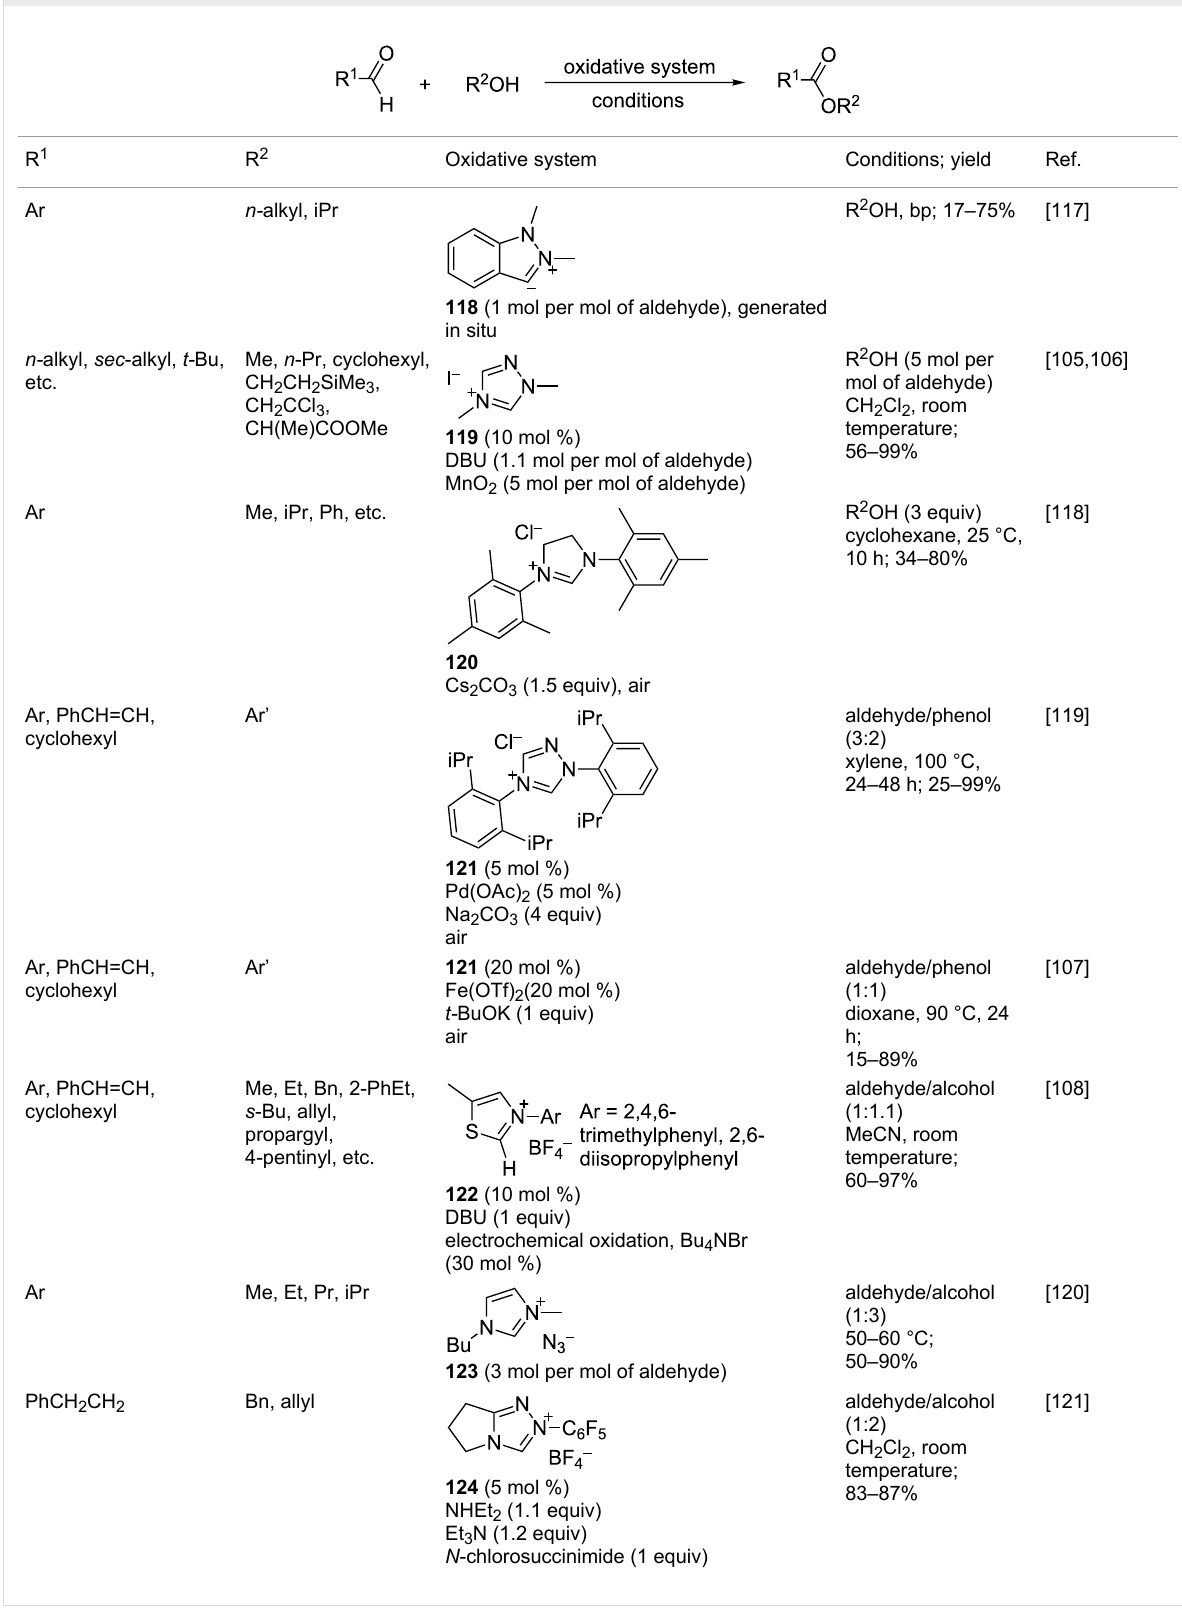
R 1 R 2 Oxidative system Conditions; yield